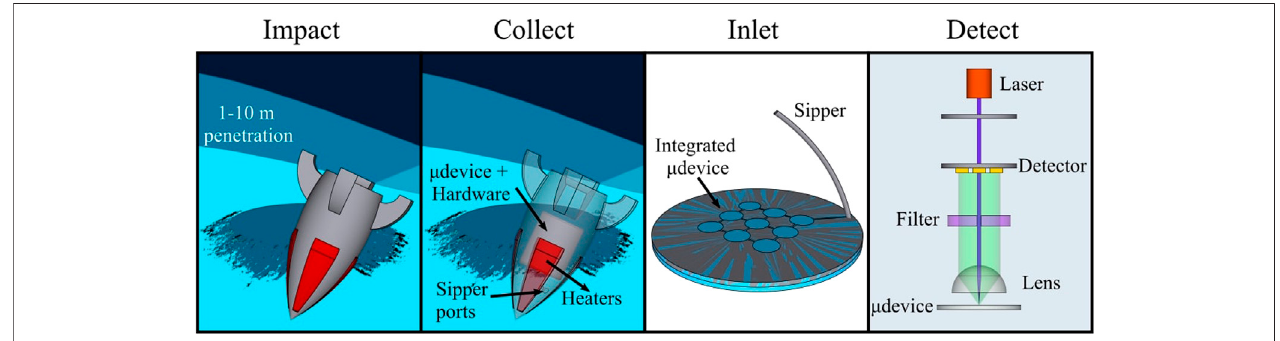
FIGURE 1 | Artist ’ s representation of the sequence of operations of an IMPOA payload for detection of organics after “ impact ” , sample “ collection ” , “ sample inlet ” into the micro fl uidic device, followed by “ detection ” .